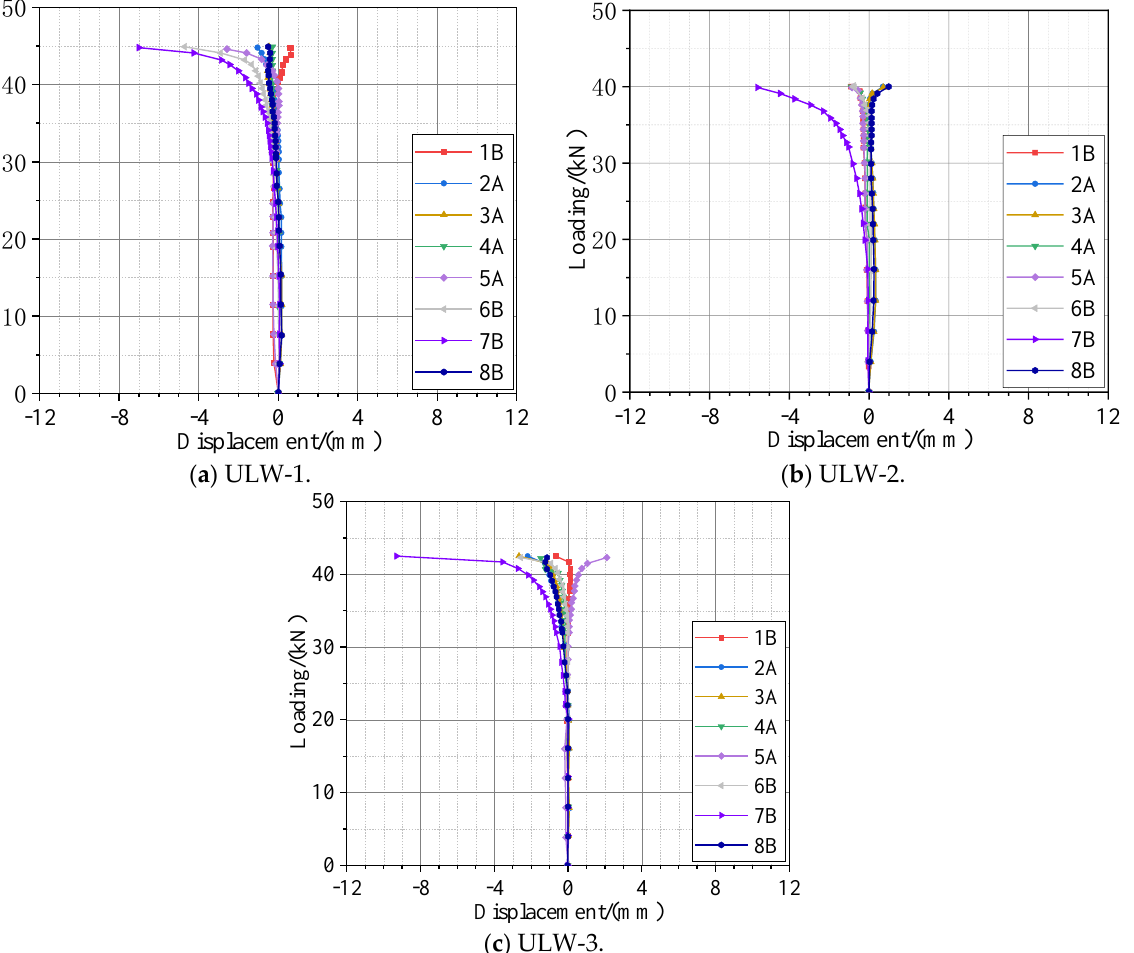
Figure 18. Loading−displacement curves of specimens in group 3. Figure 18. Loading-displacement curves of specimens in group